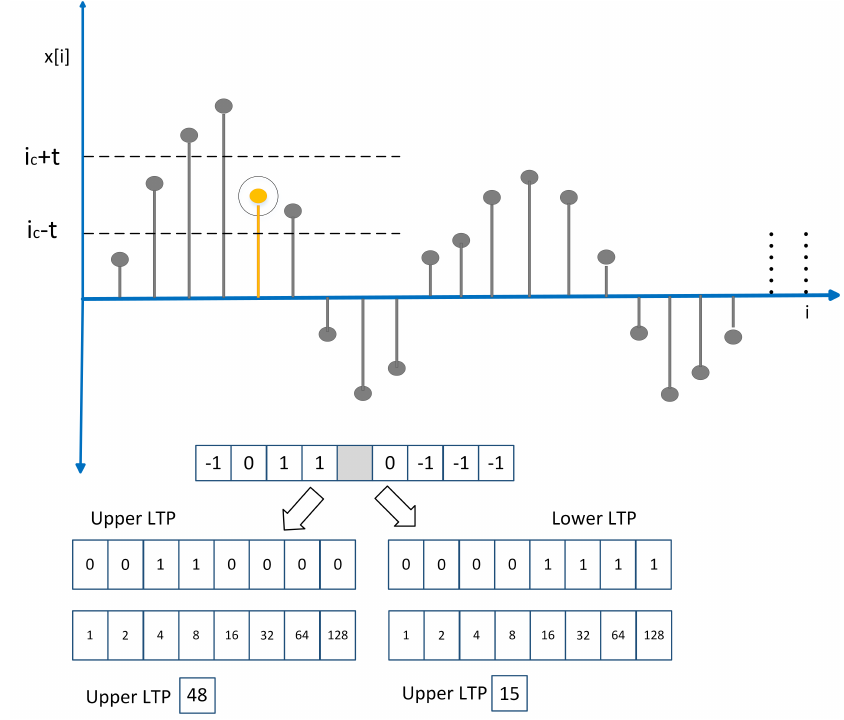
Figure 7. One-dimensional local ternary pattern (1D-LTP) feature extraction